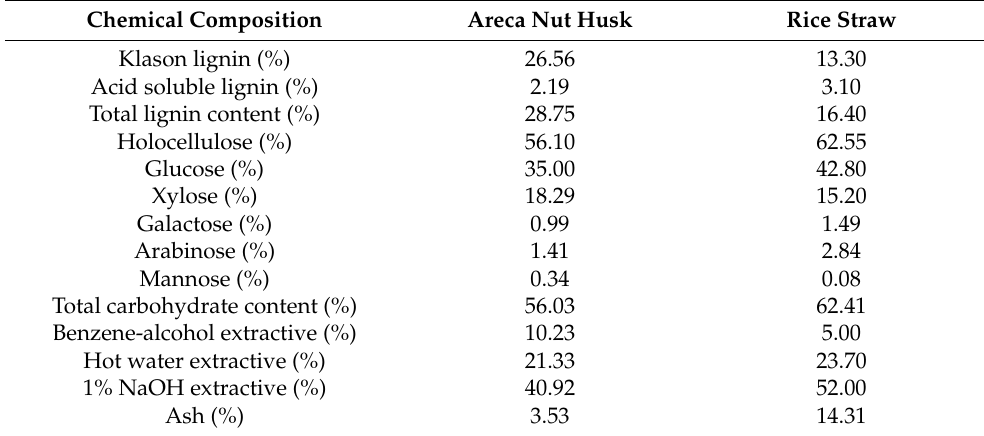
Table 1. Compositional analysis of the AH and